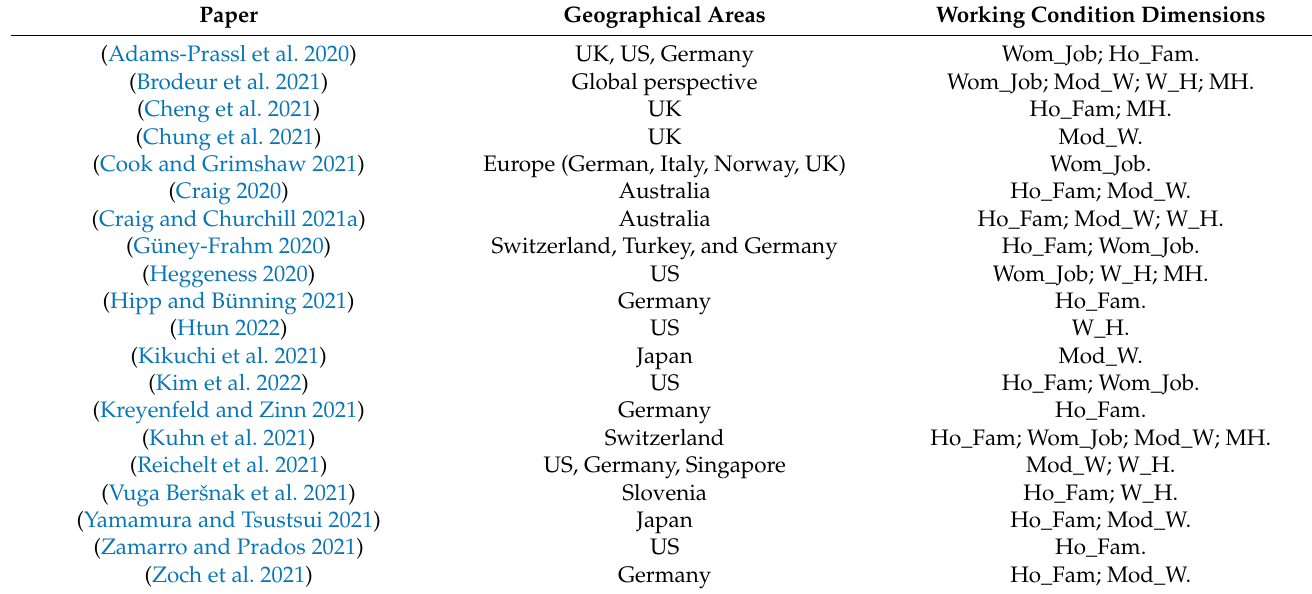
Table 2. Geographical areas and working condition dimensions studied in the papers. Legend: